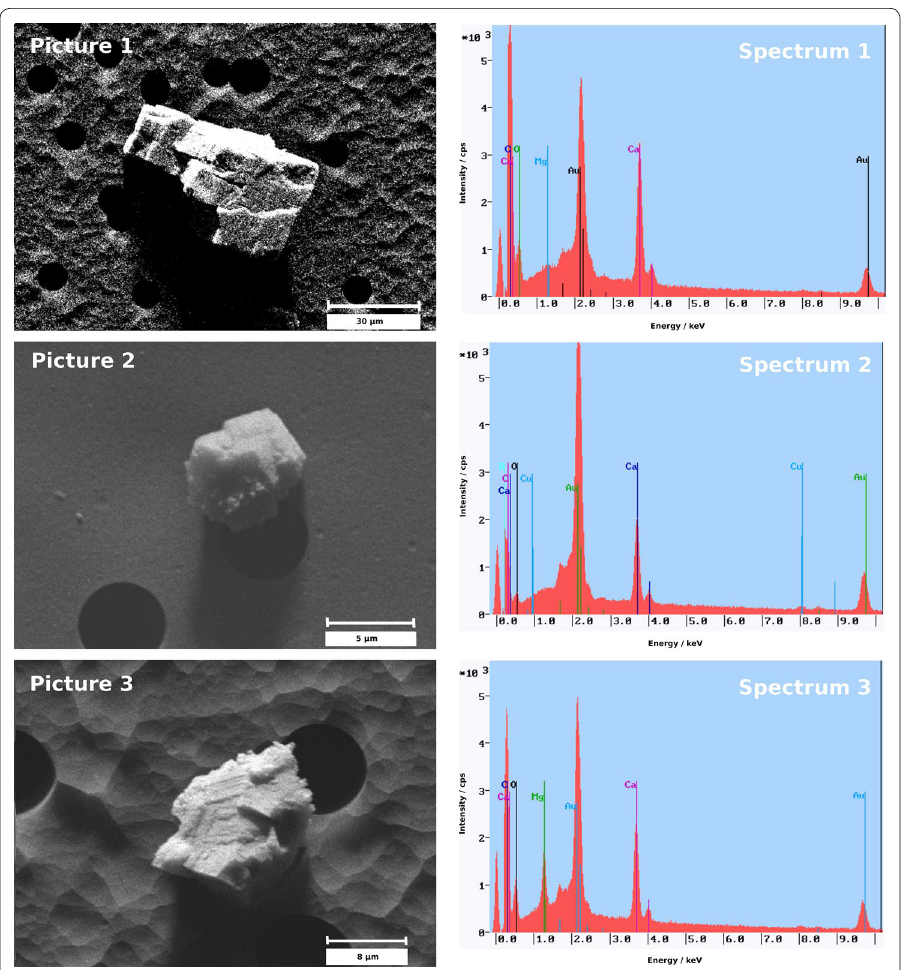
Fig. 10 Typical carbonate crystals during T Inj = 65 , 80, and 90 ◦ C : SEM picture (left) and corresponding EDX spectrum (right). Examples for injection at 80 ◦ C (Picture 2) and production at 45 ◦ C (Picture 1, T Inj = 65 ◦ C ) and at 31 ◦ C (Picture 3, T Inj = 80 ◦ C ). All pictures at these injection temperature indicate irregular calcite crystallization. Still, the morphology suggests rhombohedral calcite crystals. Some of these crystals are magnesium bearing (see Picture